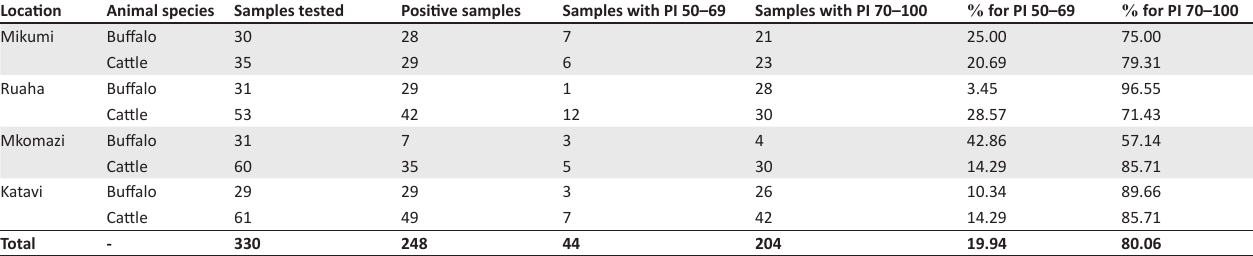
TABLE 2: Grouped PI value for buffalo and cattle samples from interface areas. Location Animal species Samples